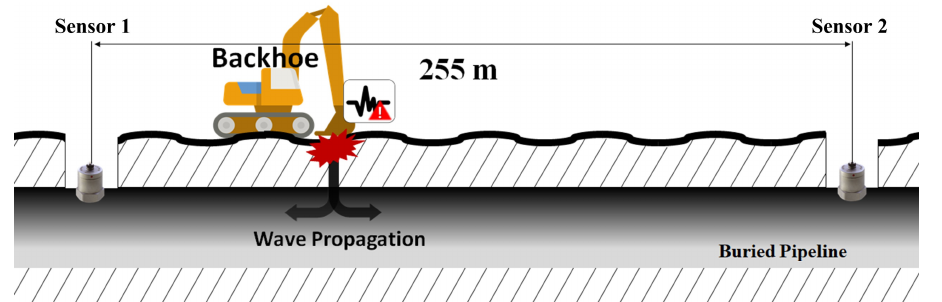
Figure 13. Illustration for the experimental scenario.